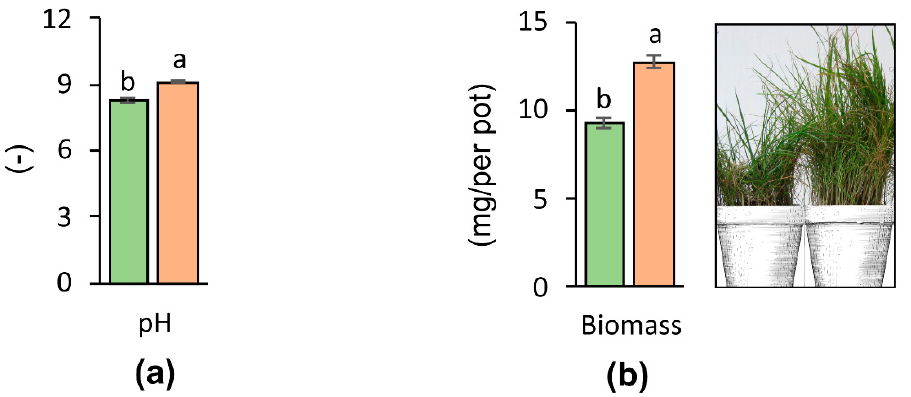
Figure 3. Soil pH ( a ) and plant biomass yield ( b ) ( ■ Control ■ nZVI). Different letters indicate significant differences in soil pH between control soil and nZVI-amended soil (a), and in biomass yield between control soil and nZVI-amended soil.